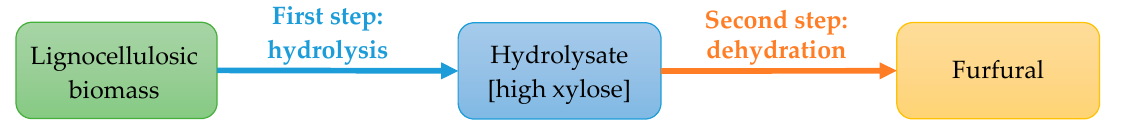
Figure 1. Schematic diagram of furfural production from lignocellulosic biomass.